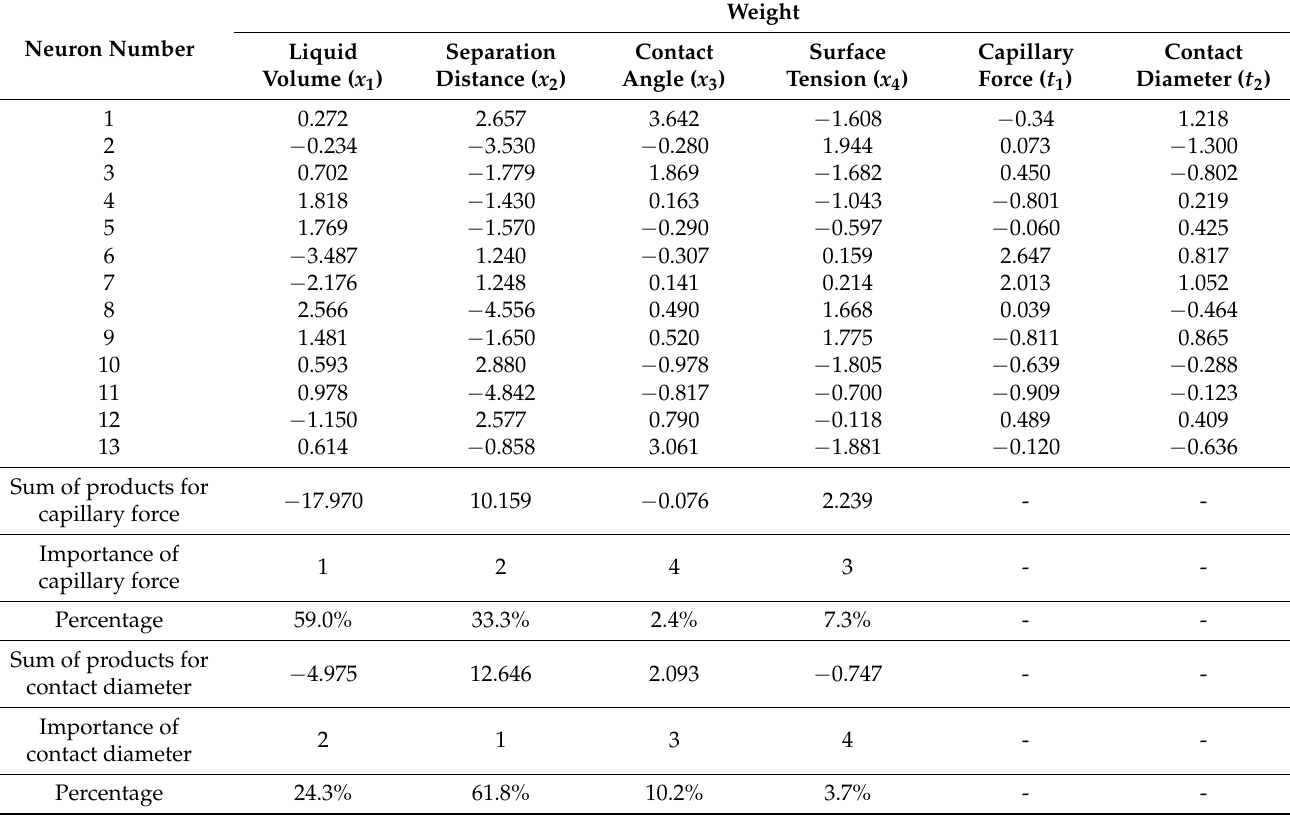
Table 4. Weights of